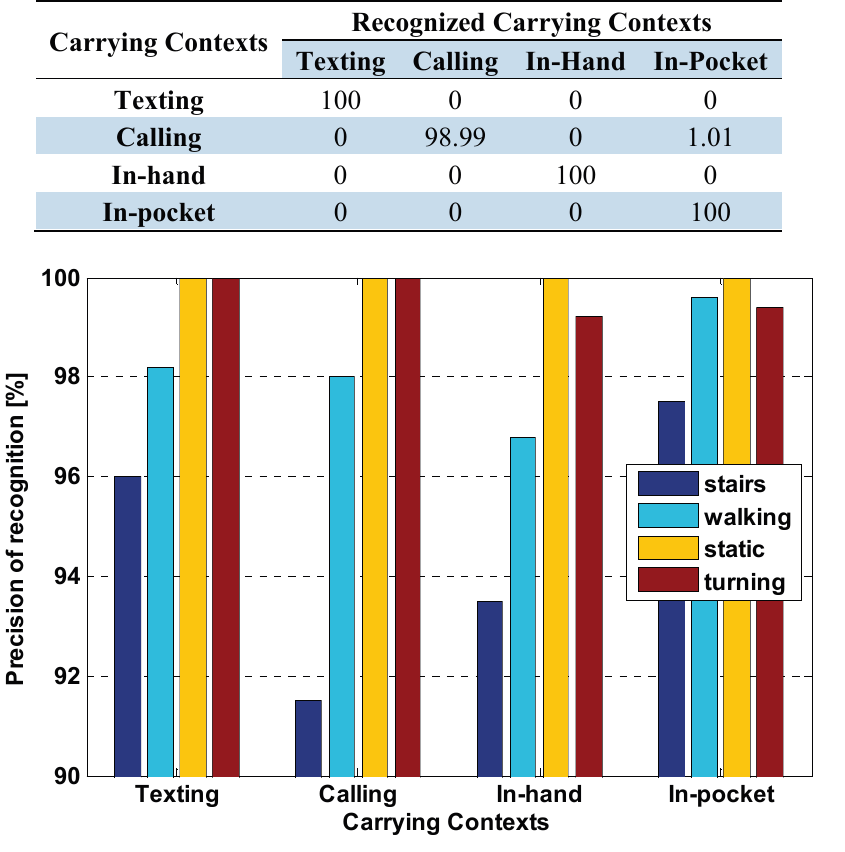
Table 1. Confusion matrix for the carrying contexts recognition (Unit: %).